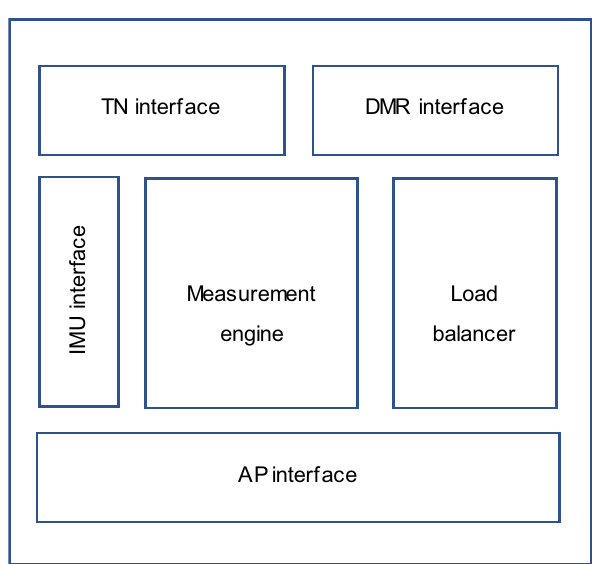
Fig. 3 Onboard processing